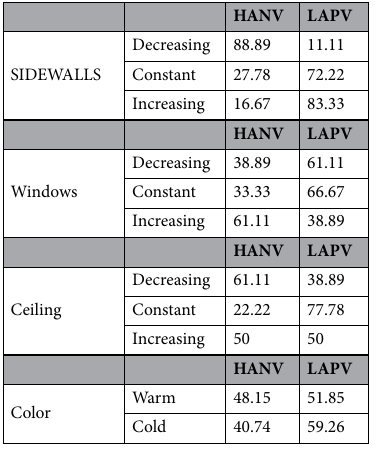
Table 1. Percentage of architectural design distribution within the clusters HANV and LAPV for each experimental